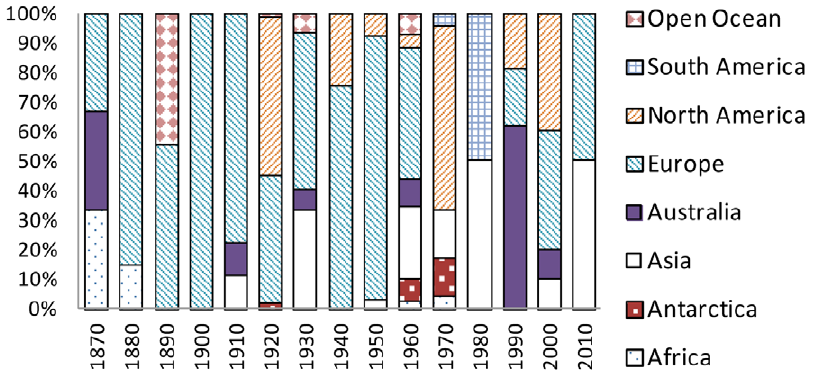
Figure 6. Proportion of original Gymnodinium descriptions from each region by decade.